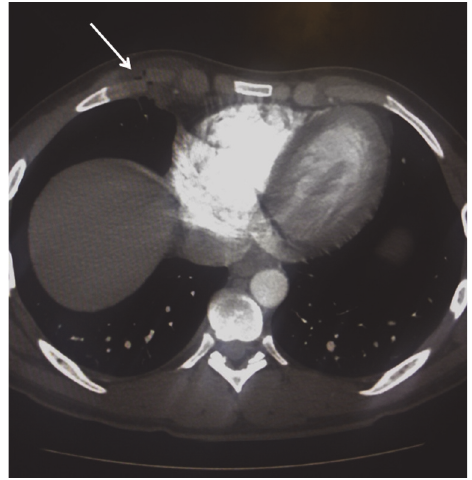
Figure 3: Axial contrast-enhanced CT 10 days after injury. Note the improvement in lung herniation